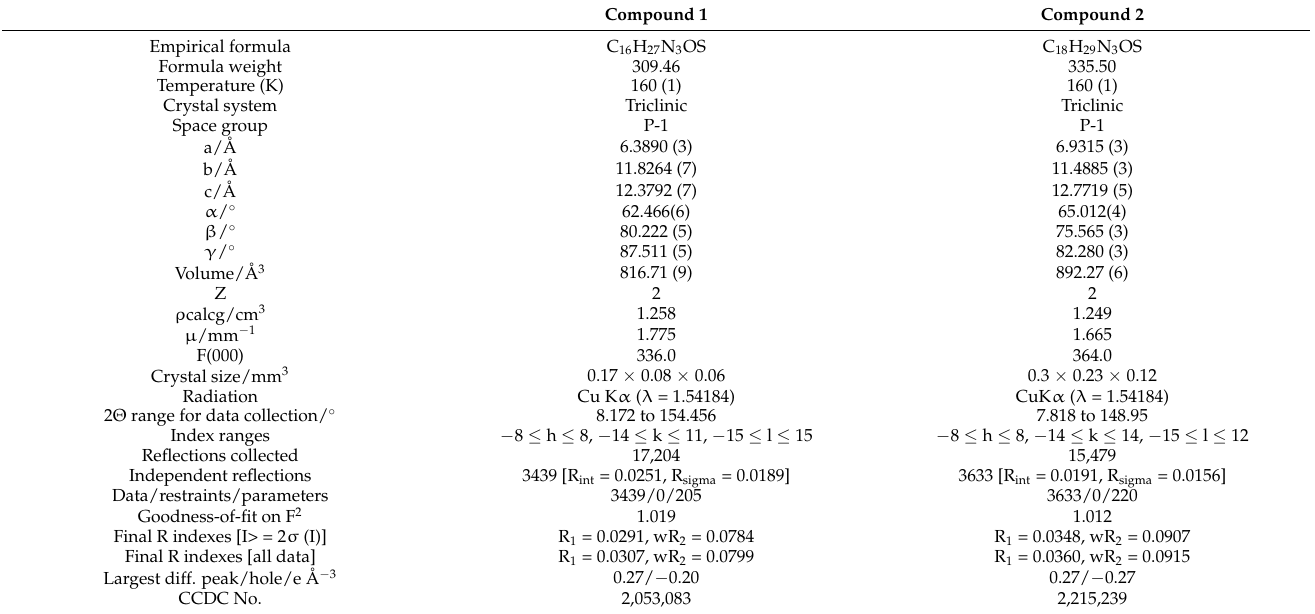
Table 1. Crystallographic data and structure refinement parameters of compounds 1 and 2